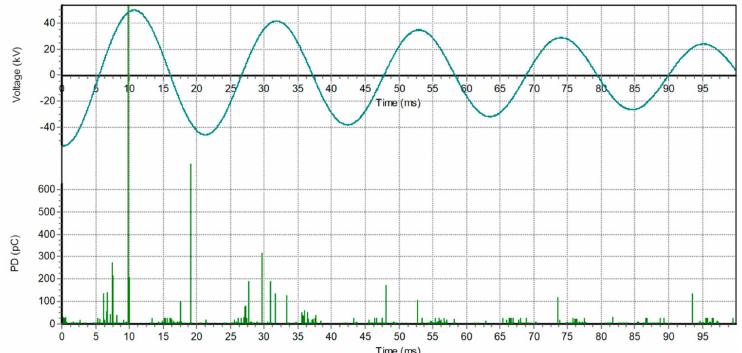
Figure 3. Example of damped AC voltage excitations monitored by partial discharge (PD)